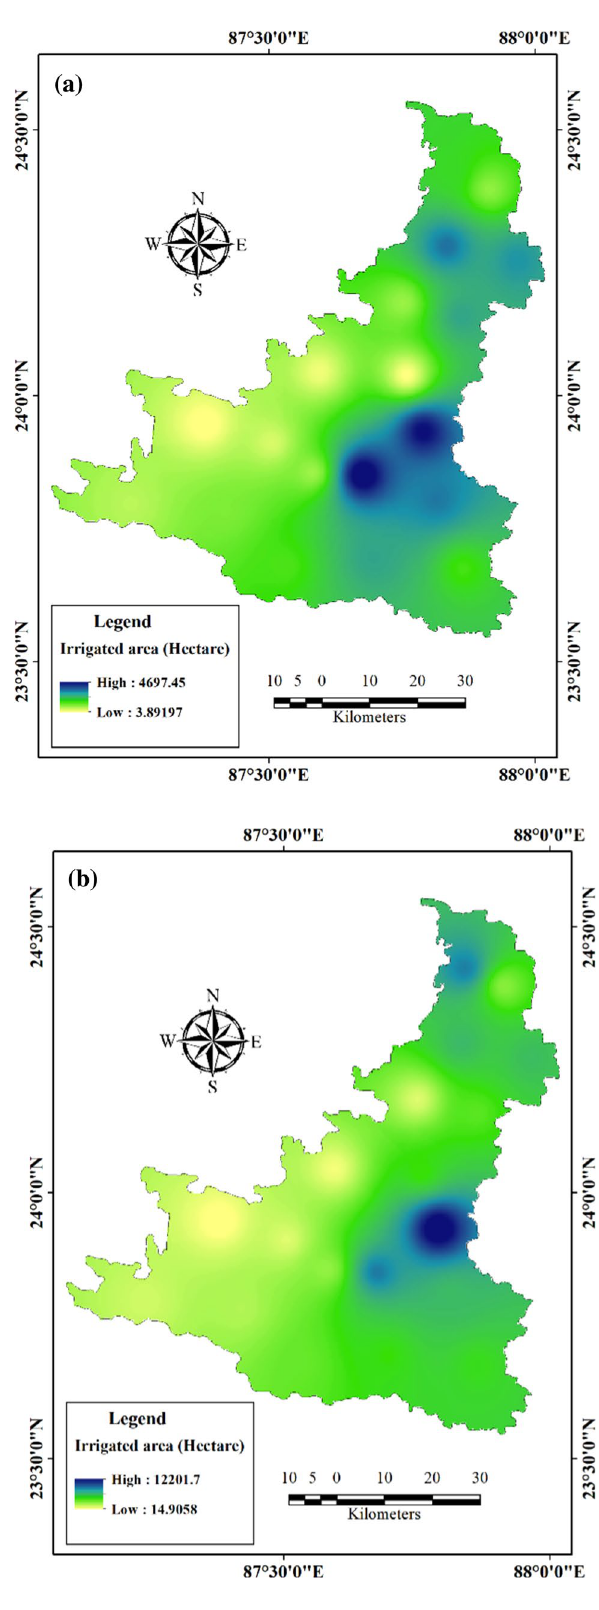
Fig. 18 Irrigated area of 1996 and